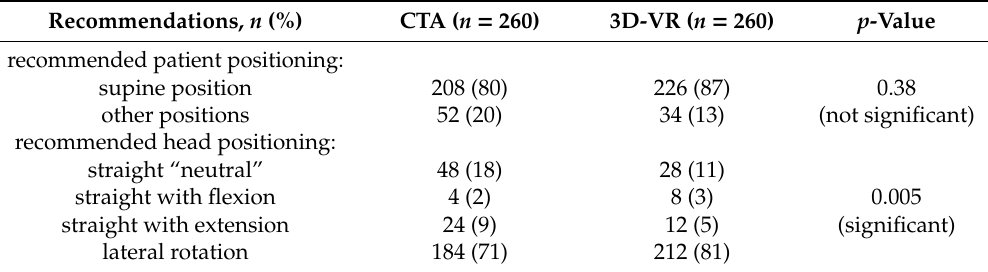
Table 4. Recommended patient and head positioning * after presenting conventional CTA images (2D and screen 3D) or reconstructed 3D-VR images, evaluated using Fisher’s exact test, assuming a p -value < 0.05 to be significant.